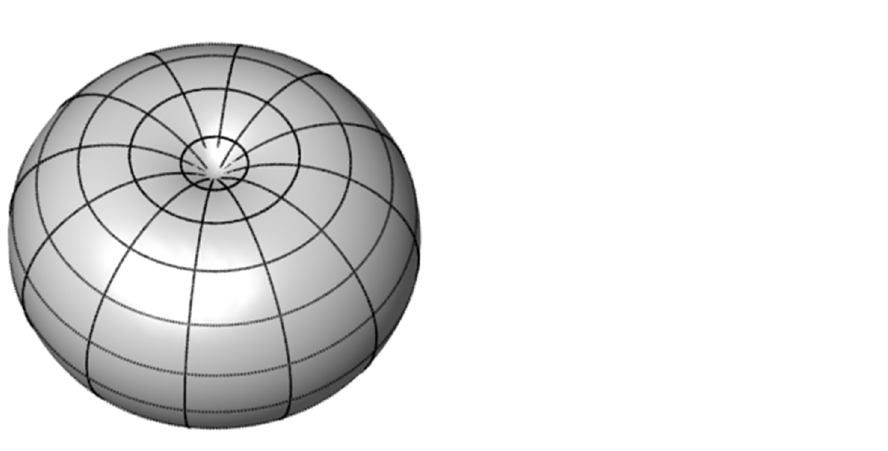
Figure 5. Spatial position distribution diagram of planetary lander based on imaging cosine.